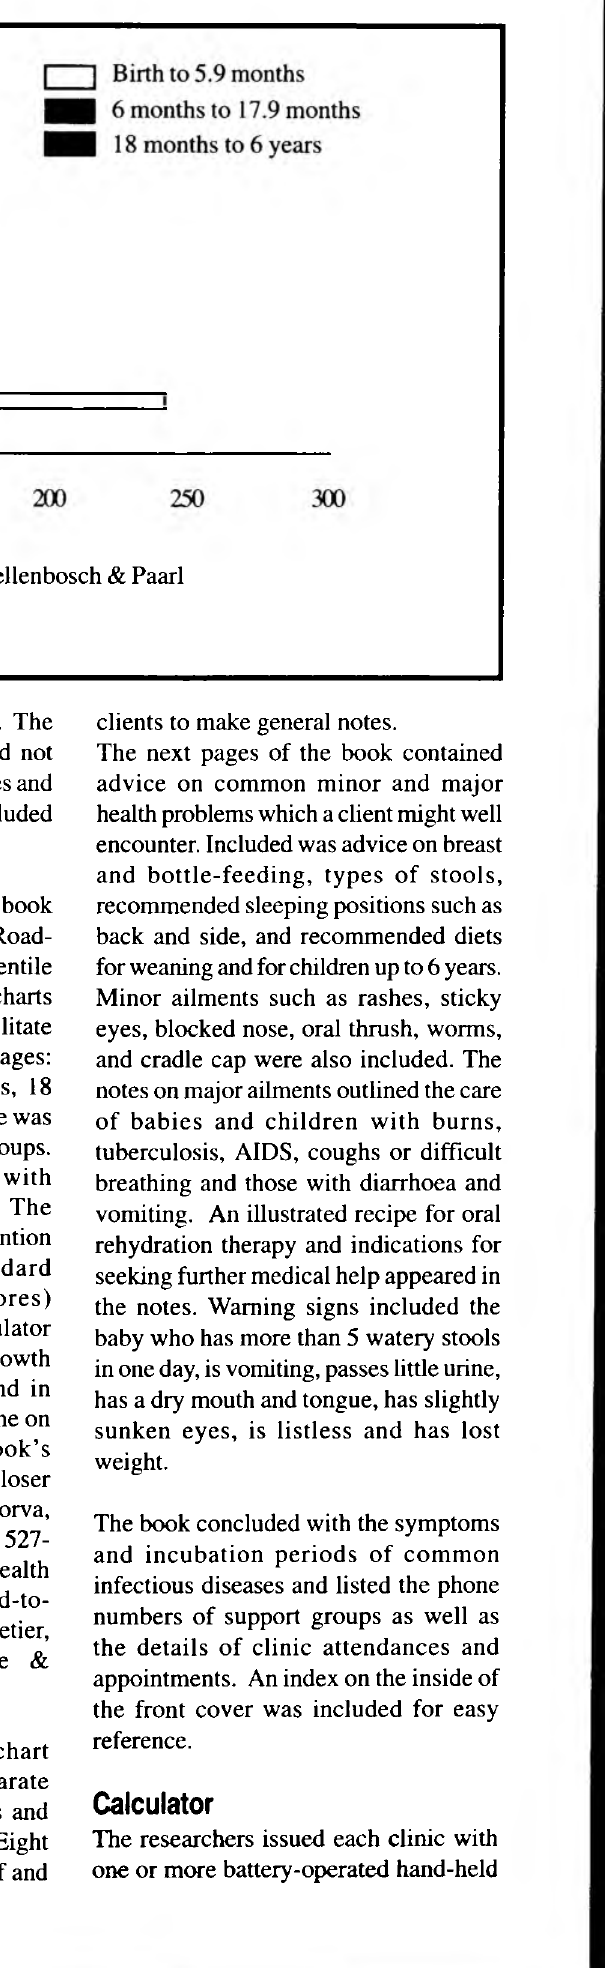
Table I : Distribution of the number of RTH books by age and